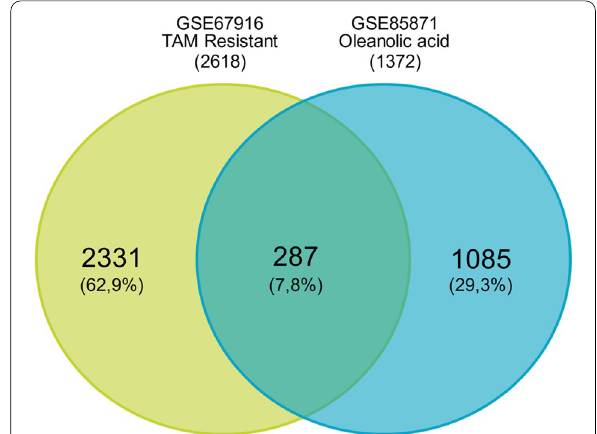
Fig. 2 Venn diagram of tamoxifen-resistant and OA-treated MCF-7 breast cancer cells. The Venn diagram’s overlap represents a group of genes expressed by MCF-7 during tamoxifen resistance and OA